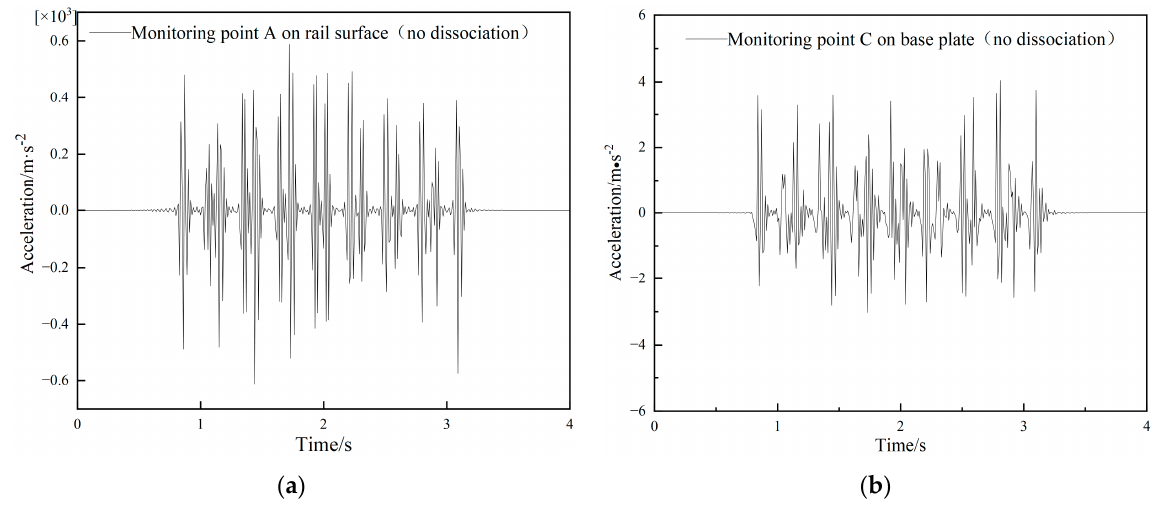
Figure 18. Calculation results of vibration acceleration under normal conditions. ( a ) acceleration time history of measuring point A, and ( b ) measuring point C.